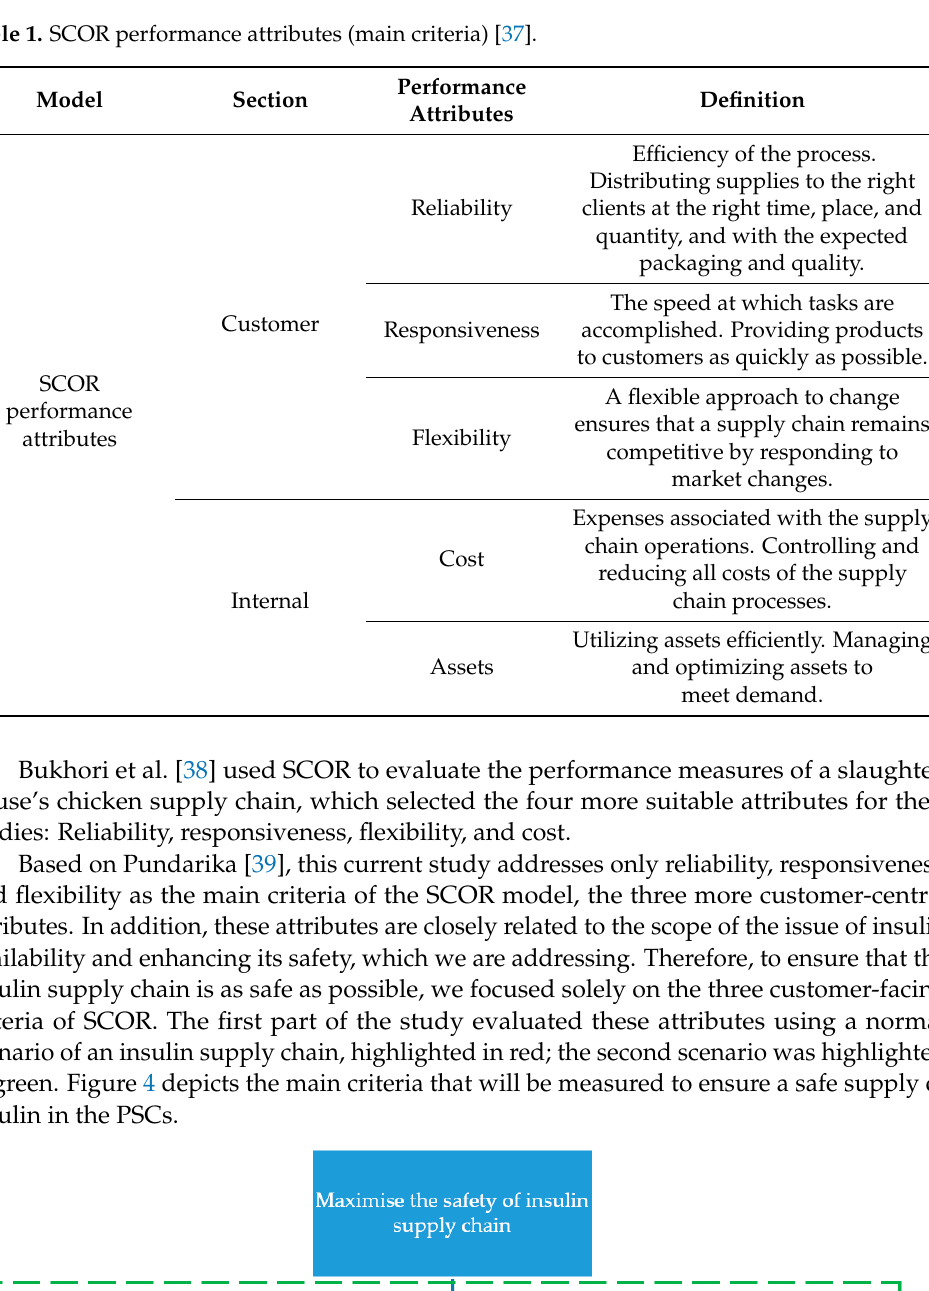
Table 1. SCOR performance attributes (main criteria) [37].